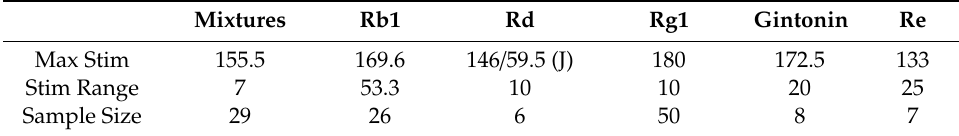
Table 4. Hormesis dose responses (median values -% stimulation).